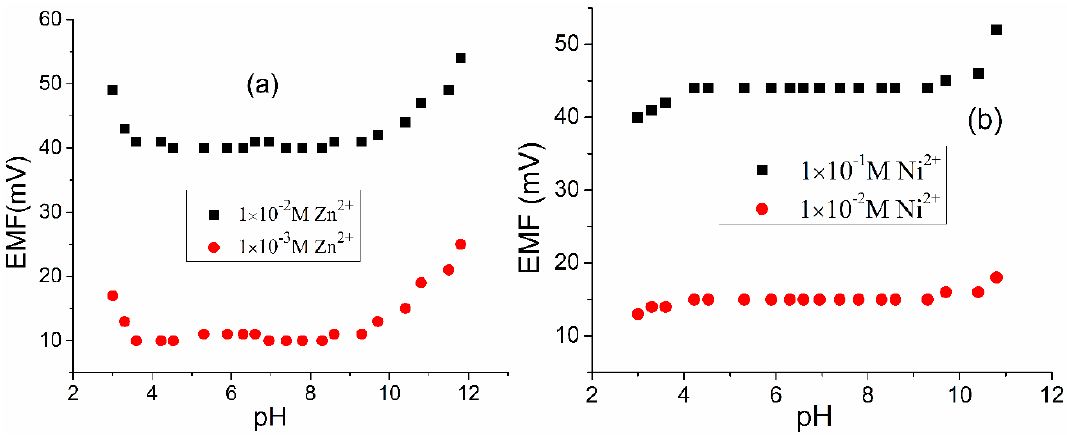
Figure 6. Effect of pH on the potential response of ( a ) Zn 2+ ISE based on DPA and ( b ) Ni 2+ ISE based on TPA.